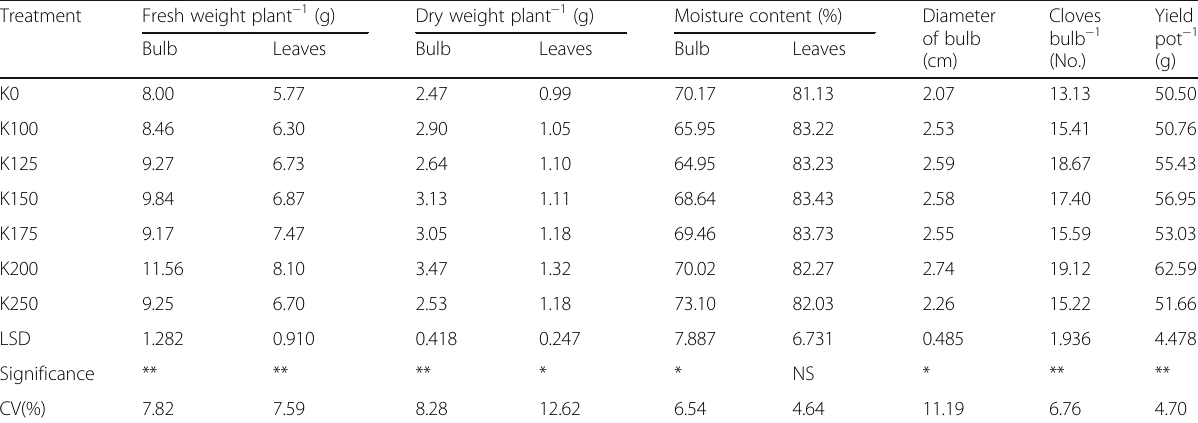
Table 2 Effect of potassium on growth, yield and quality of garlic